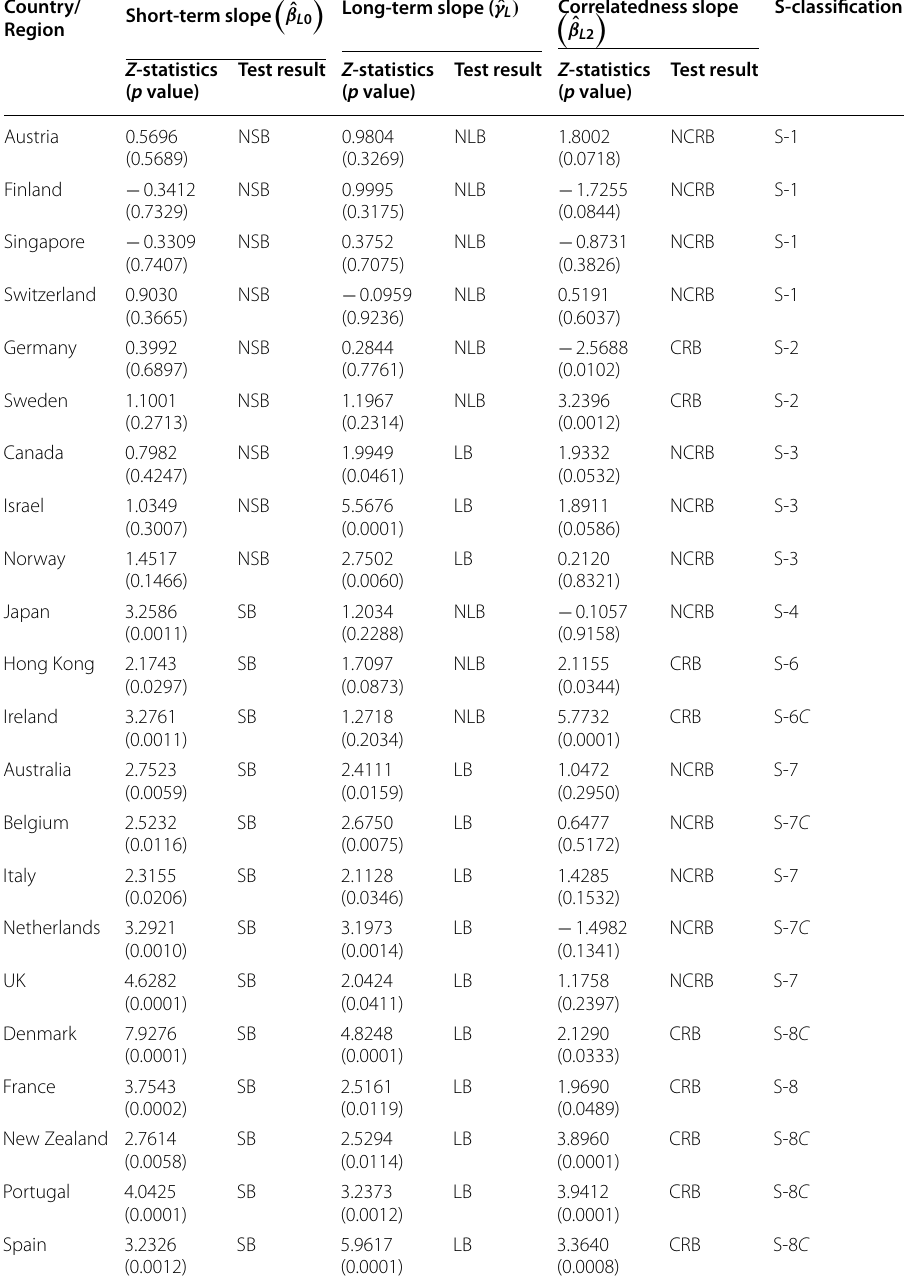
Table 3 Results of testing breaks in market structure and aggregate equity